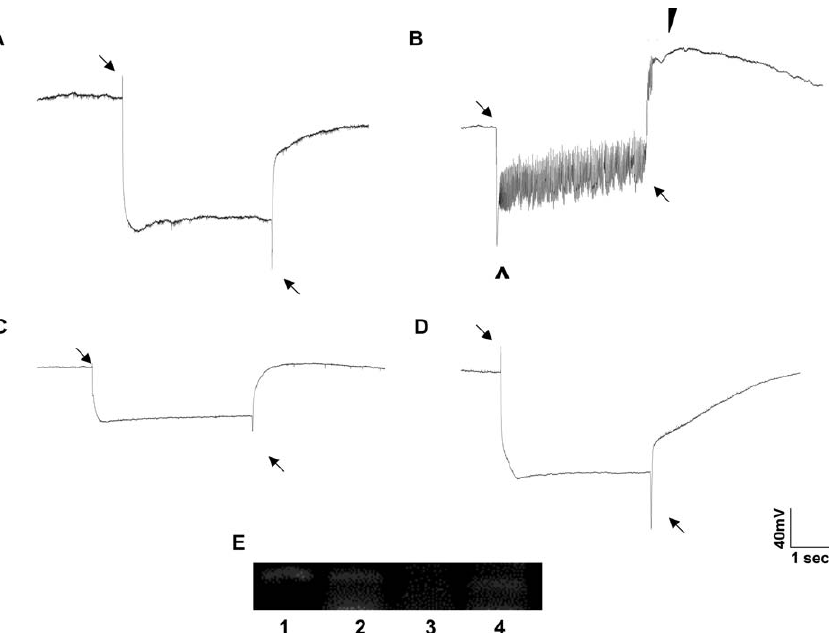
Figure 1. Rescue of ine 2 -Associated Oscillations with Expression of INE in Both Glial and Photoreceptor Cells ERG recordings from (A) wild type, (B) ine 2 , (C) ine 2 expressing the UAS-ineRB cDNA in photoreceptors, and (D) ine 2 expressing the UAS-ineRB cDNA in glial cells. Arrows indicate on and off transients present in (A) wild-type but not (B) ine 2 mutant recordings. A sharp depolarization response (unfilled arrowhead), a hyperpolarization (filled arrowhead) response and oscillations are present in (B) ine 2 ERG recordings. Note that ine expression in either photoreceptor or glial cells results in a rescue of ine 2 -associated oscillations, on and off transients (arrows), and the hyperpolarization response. (E) Measurement of ine-RA and ine-RB mRNA in wild-type embryos or adult heads. 1 ¼ ine-RA product from adult heads, 2 ¼ ine-RA product from embryos, 3 ¼ ine-RB product from adult heads, and 4 ¼ ine-RB product from embryos. The ine-RA PCR product is 336 bp, while the ine-RB product is 338 bp. Note that there is very little ine-RB mRNA found in adult heads.